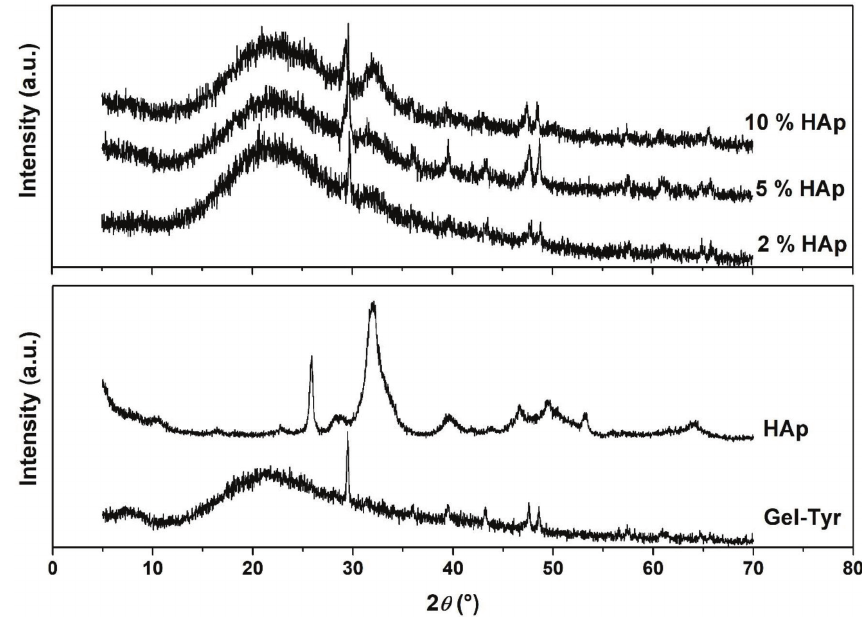
Fig. 3 – Diffraction patterns of gelatine (Gel-Tyr), hydroxyapatite (HAp) and Gel-Tyr/HAp composites with different HAp content (2 % HAp, 5 % HAp, and 10 %